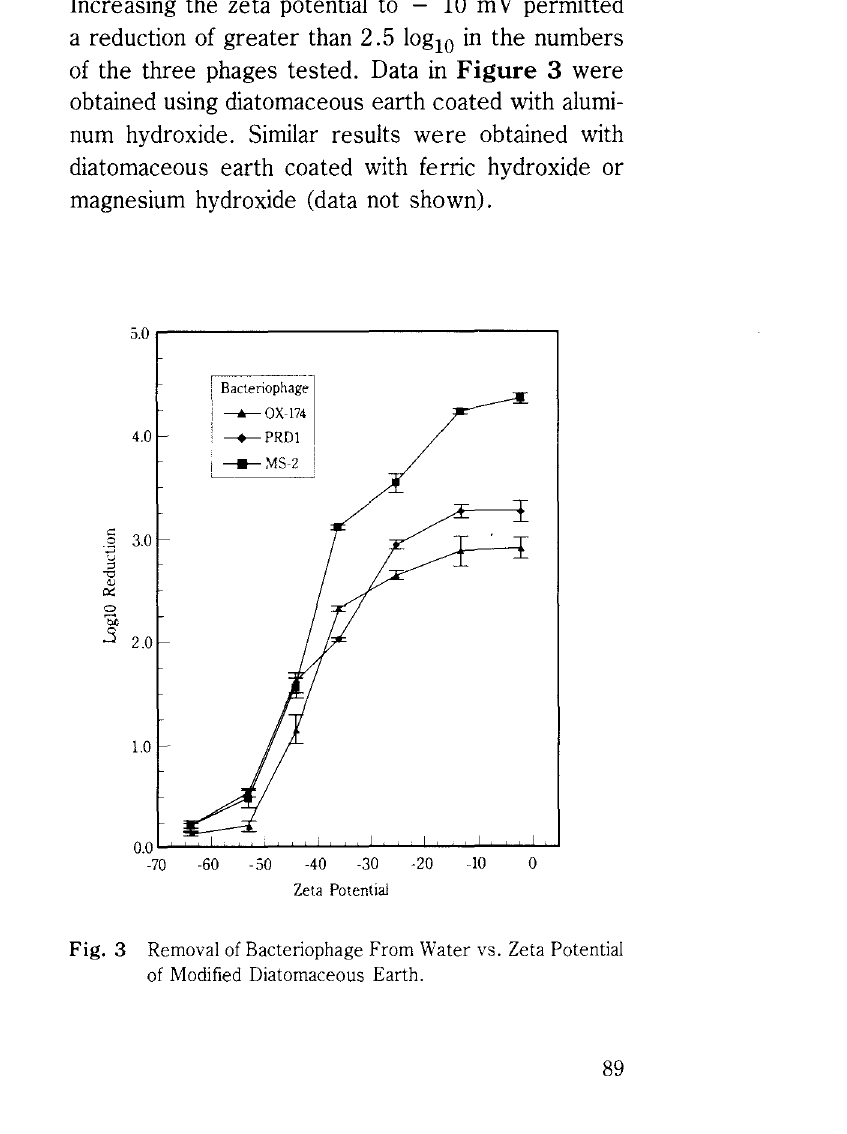
Fig. 3 Removal of Bacteriophage From Water vs. Zeta Potential of Modified Diatomaceous